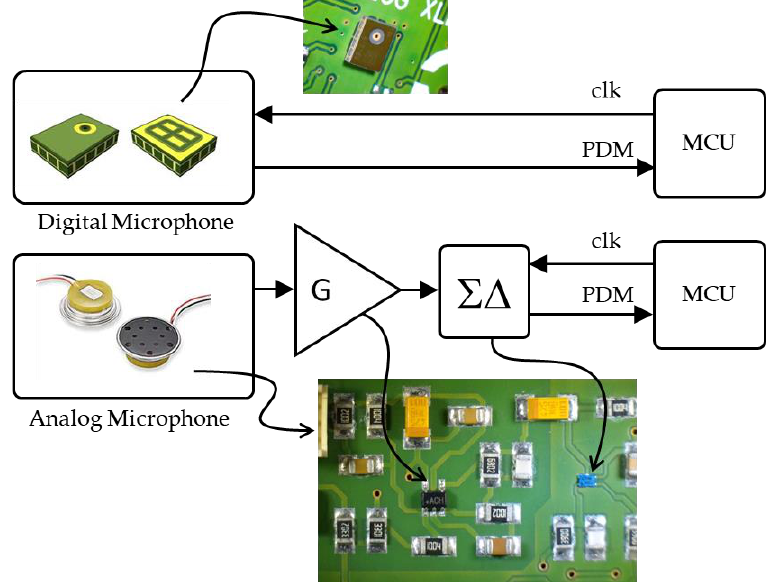
Figure 2. Microphone options. Top: digital, Bottom: